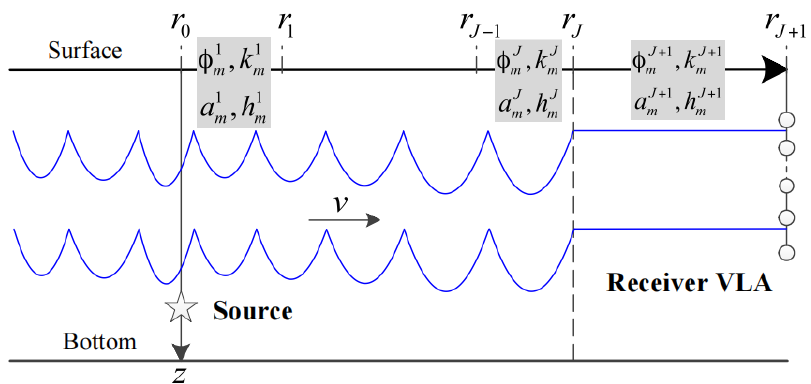
Figure 15. Source ‐ receiver geometry with a train of traveling ISWs. Figure 15. Source-receiver geometry with a train of traveling ISWs. The range-dependent region 0 < r ≤ r J is subdivided equally into J segments, and the medium within each within each segment is assumed to be range-independent. The range-independent region r J < r ≤ r J + 1 is treated as one segment. According to the coupled normal modes theory, the sound pressure received at the ( J + 1)th segment can be expressed as